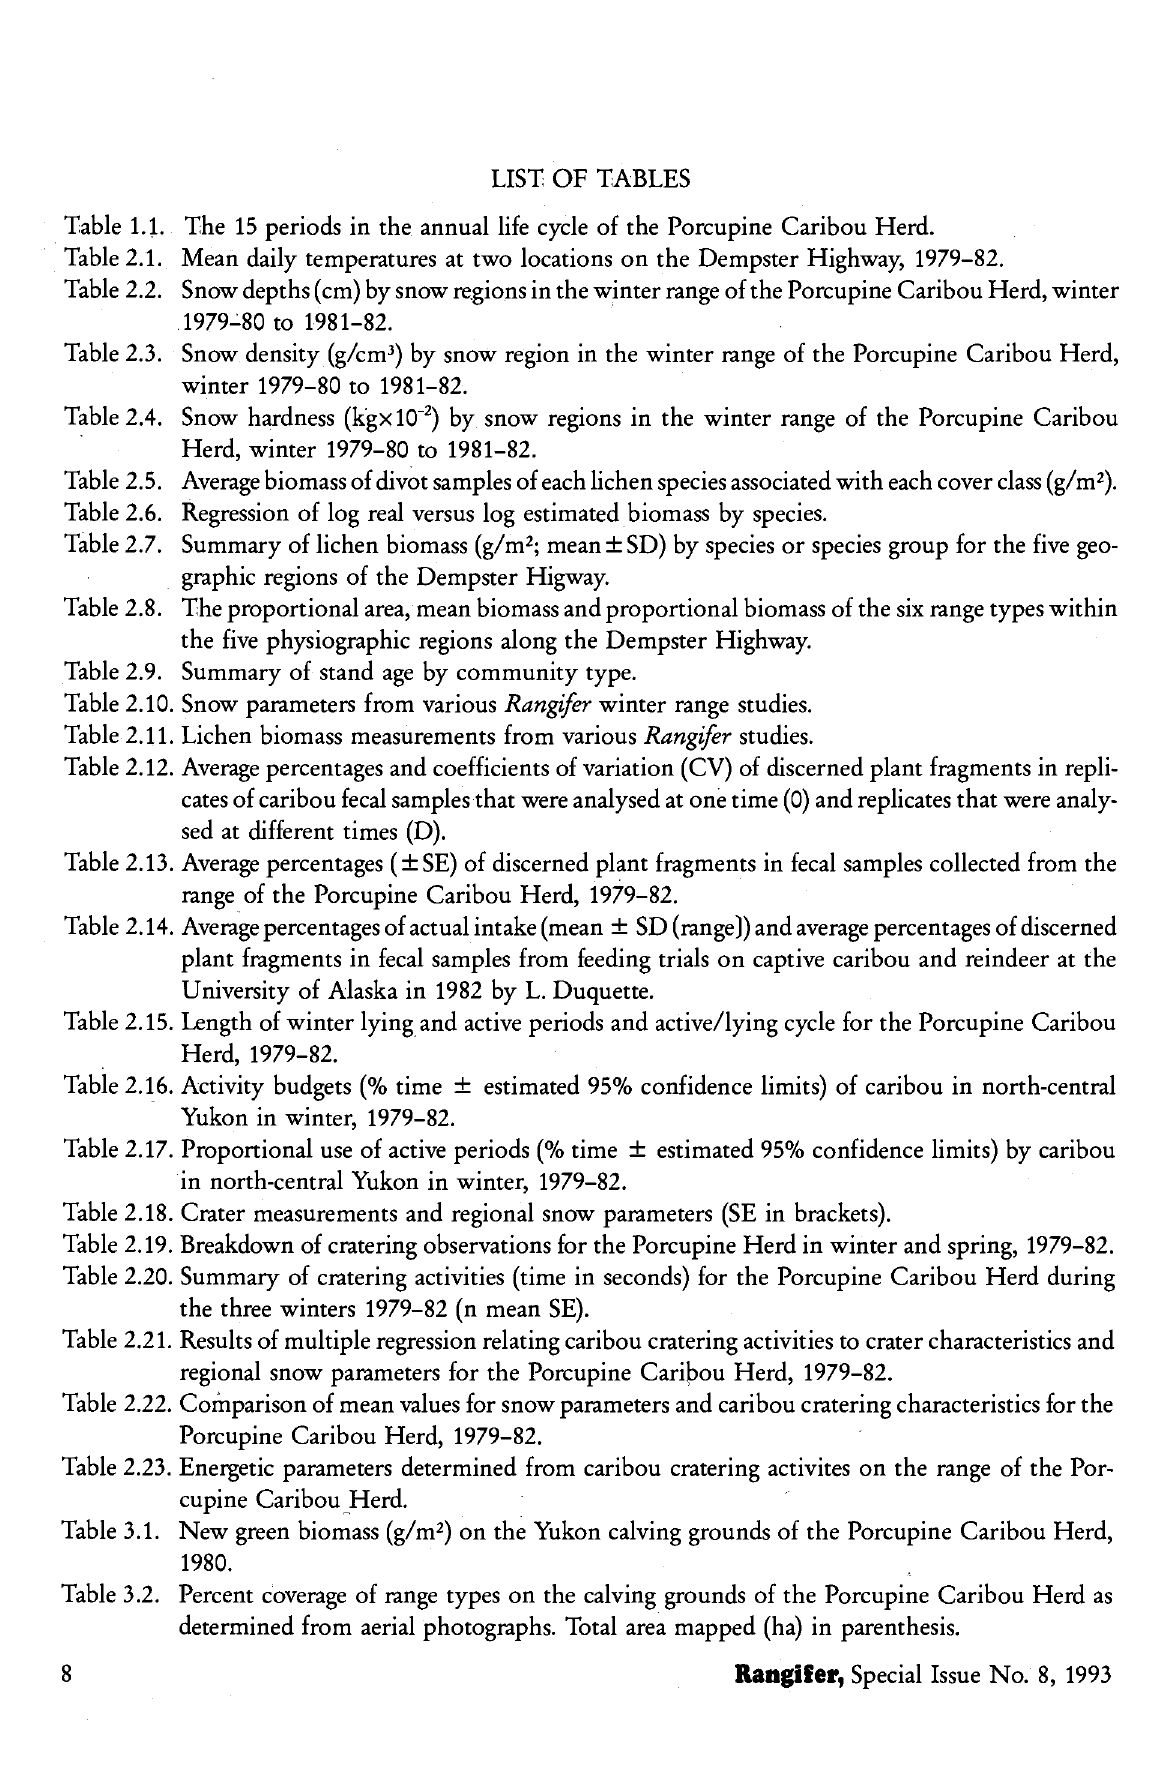
Table 1.1. The 15 periods in the annual life cycle of the Porcupine Caribou Herd. Table 2.1. Mean daily temperatures at two locations on the Dempster Highway, 1979-82. Table 2.2. Snow depths (cm) by snow regions in the winter range of the Porcupine Caribou Herd, winter 1979-80 to 1981-82. Table 2.3. Snow density (g/cm 3 ) by snow region in the winter range of the Porcupine Caribou Herd, winter 1979-80 to 1981-82. Table 2.4. Snow hardness (kgx 10" 2 ) by snow regions in the winter range of the Porcupine Caribou Herd, winter 1979-80 to 1981-82. Table 2.5. Average biomass of divot samples of each lichen species associated with each cover class (g/m 2 ). Table 2.6. Regression of log real versus log estimated biomass by species. Table 2.7. Summary of lichen biomass (g/m 2 ; mean±SD) by species or species group for the five geo graphic regions of the Dempster Higway. Table 2.8. The proportional area, mean biomass and proportional biomass of the six range types within the five physiographic regions along the Dempster Highway. Table 2.9. Summary of stand age by community type. Table 2.10. Snow parameters from various Rangifer winter range studies. Table 2.11. Lichen biomass measurements from various Rangifer studies. Table 2.12. Average percentages and coefficients of variation (CV) of discerned plant fragments in repli cates of caribou fecal samples that were analysed at one time (0) and replicates that were analy sed at different times (D). Table 2.13. Average percentages ( ± SE) of discerned plant fragments in fecal samples collected from the range of the Porcupine Caribou Herd, 1979-82. Table 2.14. Average percentages of actual intake (mean ± SD (range]) and average percentages of discerned plant fragments in fecal samples from feeding trials on captive caribou and reindeer at the University of Alaska in 1982 by L. Duquette. Table 2.15. Length of winter lying and active periods and active/lying cycle for the Porcupine Caribou Herd, 1979-82. Table 2.16. Activity budgets (% time ± estimated 95% confidence limits) of caribou in north-central Yukon in winter, 1979-82. Table 2.17. Proportional use of active periods (% time ± estimated 95% confidence limits) by caribou in north-central Yukon in winter, 1979-82. Table 2.18. Crater measurements and regional snow parameters (SE in brackets). Table 2.19. Breakdown of cratering observations for the Porcupine Herd in winter and spring, 1979-82. Table 2.20. Summary of cratering activities (time in seconds) for the Porcupine Caribou Herd during the three winters 1979-82 (n mean SE). Table 2.21. Results of multiple regression relating caribou cratering activities to crater characteristics and regional snow parameters for the Porcupine Caribou Herd, 1979-82. Table 2.22. Comparison of mean values for snow parameters and caribou cratering characteristics for the Porcupine Caribou Herd, 1979-82. Table 2.23. Energetic parameters determined from caribou cratering activités on the range of the Por cupine Caribou Herd. Table 3.1. New green biomass (g/m 2 ) on the Yukon calving grounds of the Porcupine Caribou Herd, 1980. Table 3.2. Percent coverage of range types on the calving grounds of the Porcupine Caribou Herd as determined from aerial photographs. Total area mapped (ha) in